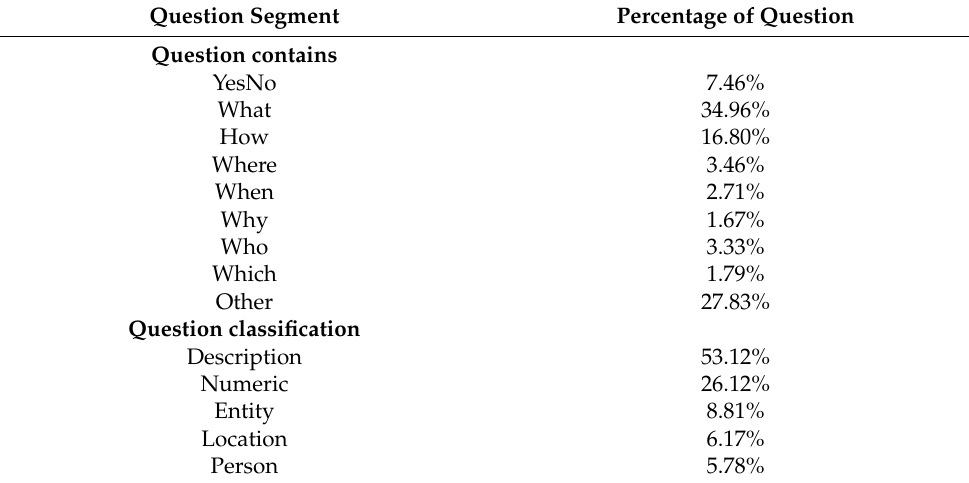
Table 4. Distribution of questions based on the answer-type question classifier and the proportion of the questions that exactly contain the specific word in MS MARCO. This table is adopted from [9].